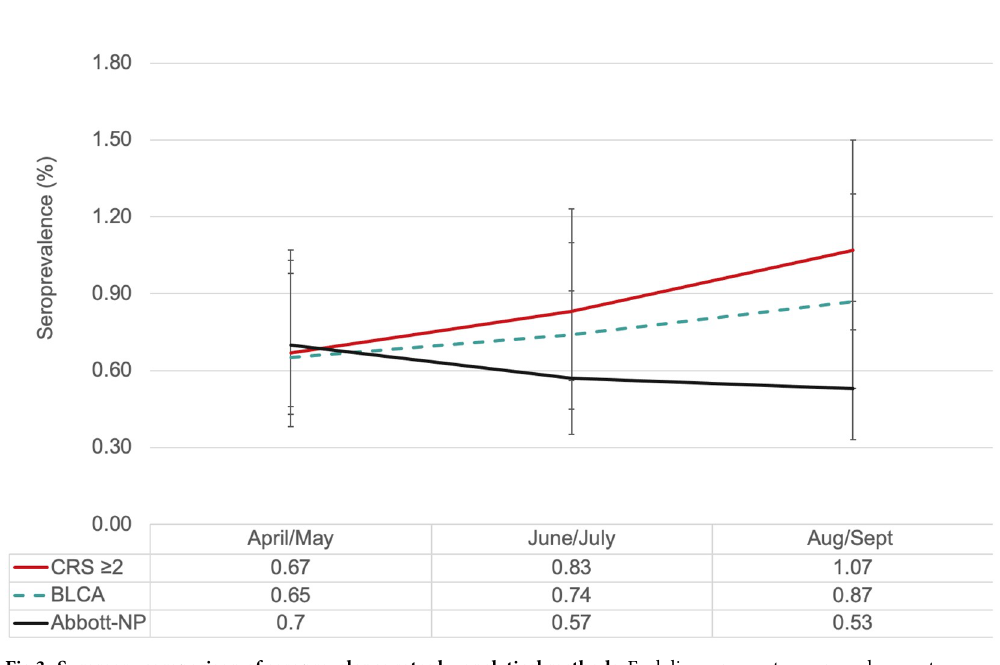
Fig 3. Summary comparison of seroprevalence rates by analytical methods. Each line represents seroprevalence rates (summarized in table below) derived from four analytical methods bi-monthly between April and September 2020 (during the first COVID-19 Wave). > = 2 proteins (positivity was determined by a reactive sample from two or more assays), BLCA-Bayesian latent class analysis with informative priors, results are posterior means and error bars are 95% CrI and Abbott-NP is a single commercial